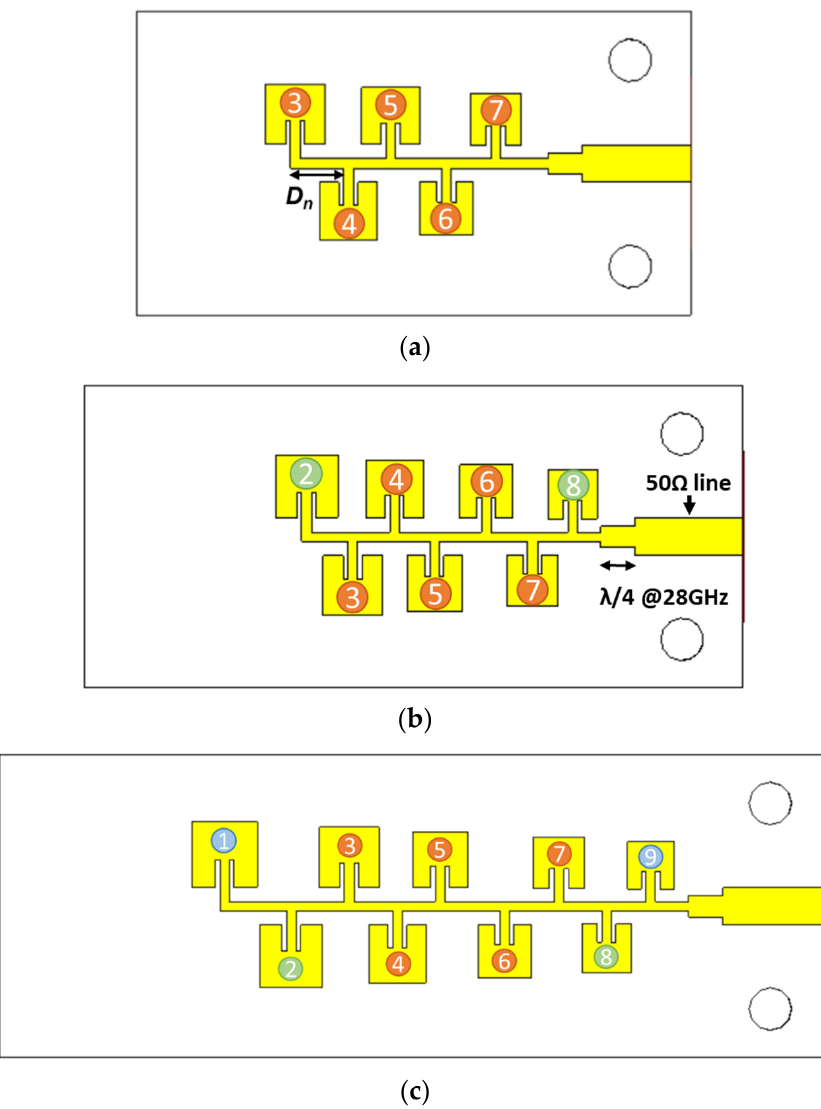
Figure 3. Designed microstrip antenna arrays using a log periodic structure with ( a ) n = 5 elements ( b ) n = 7 elements and ( c ) n = 9